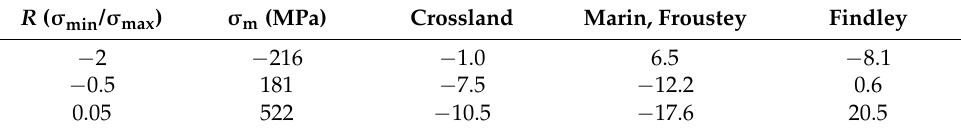
Table 5. Relative errors (%) of the different theories: Crossland [30], Marin [17], Froustey [31] and Findley [32] for N = 2 × 10 6 cycles. Positive values mean conservative results predicted by the theory, negative values non-conservative